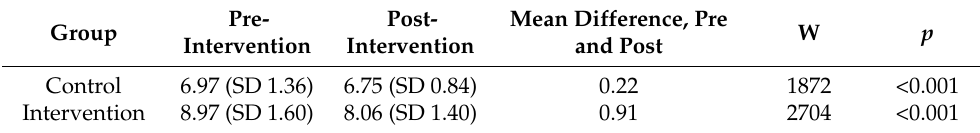
Table 2. HbA1c Means pre and post